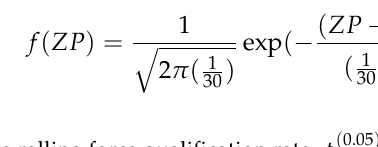
Table 3. Comparison of the rolling force qualification rate, φ